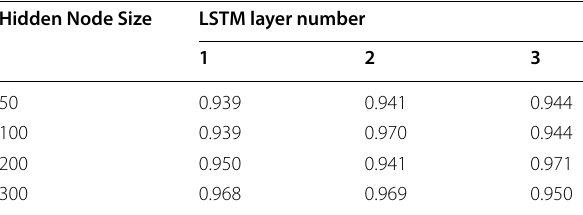
Table 9 LSTM hidden size and layer number evaluation experiment on TTPs Phishing, using F1 score